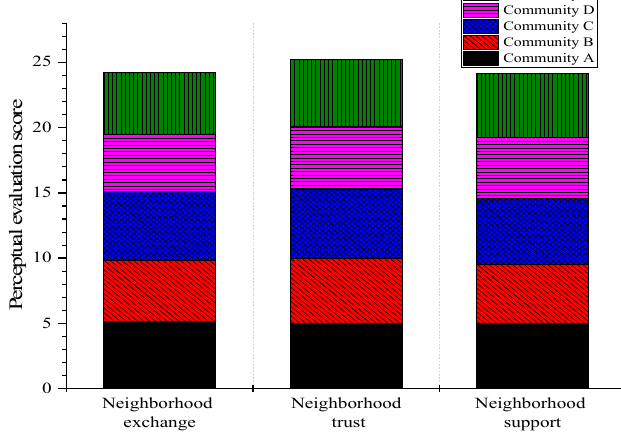
Figure 6. Evaluation scores of social environment perception in each community.